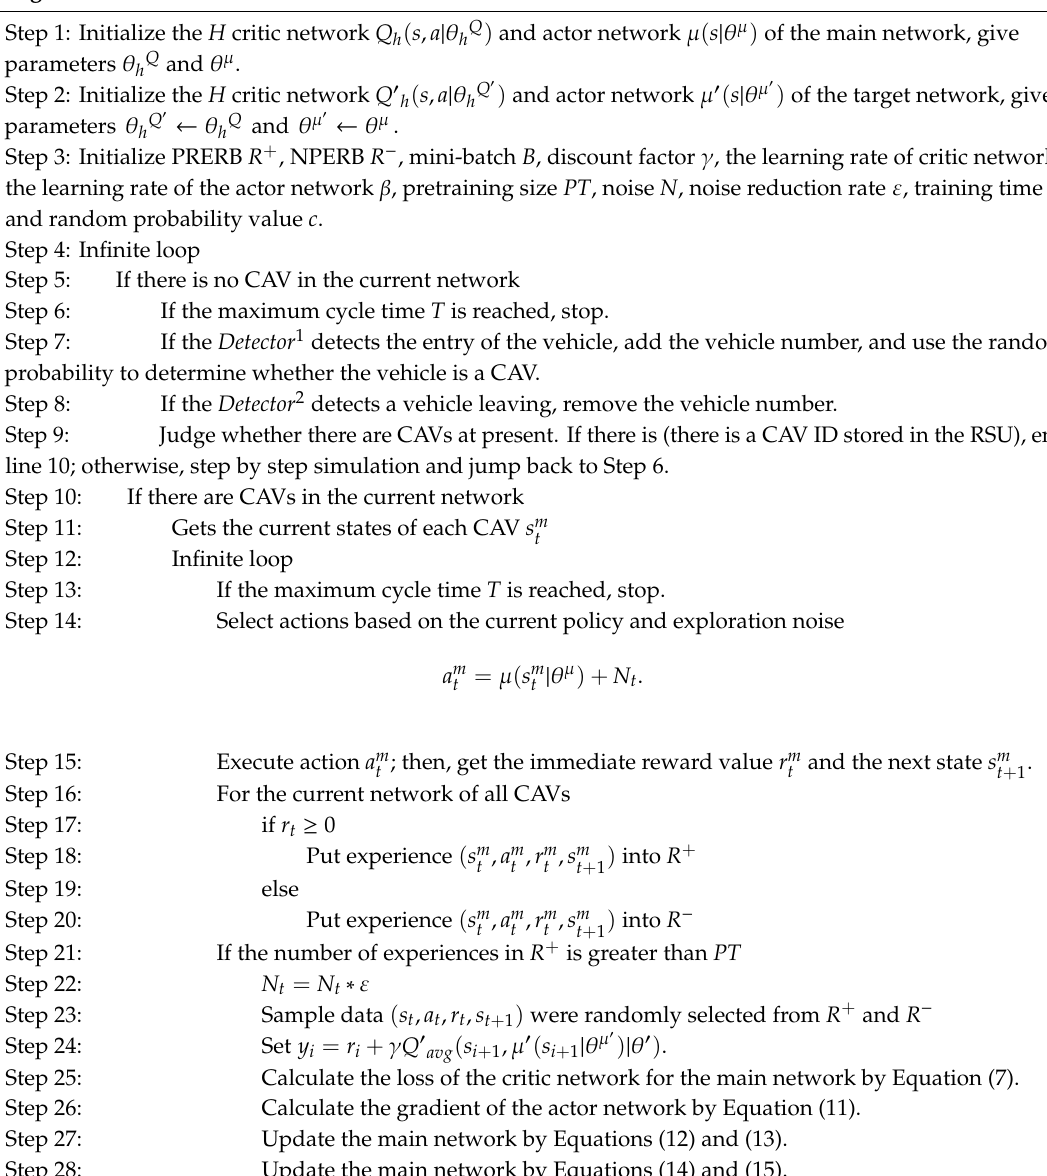
Algorithm 1 PNRERB-MC-DDPG